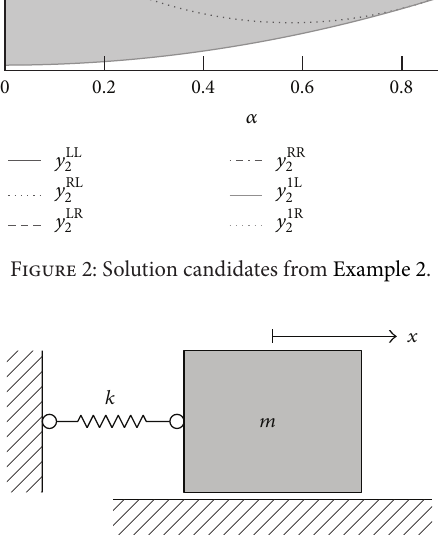
Figure 3: Mass-spring